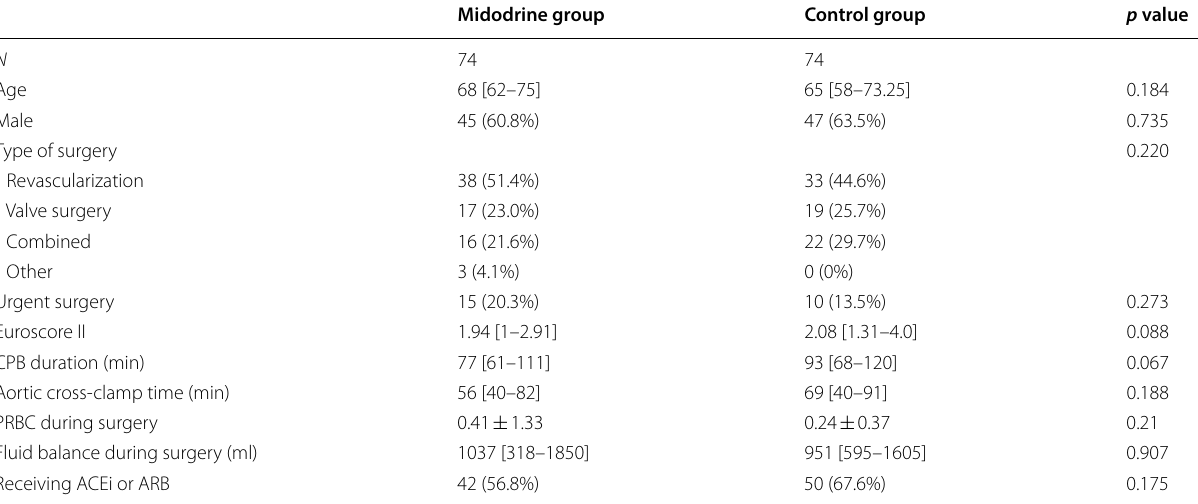
ACEi angiotensin conversion enzyme inhibitors, ARB angiotensin receptor blockers, CPB cardiopulmonary bypass, PRBC packed red blood